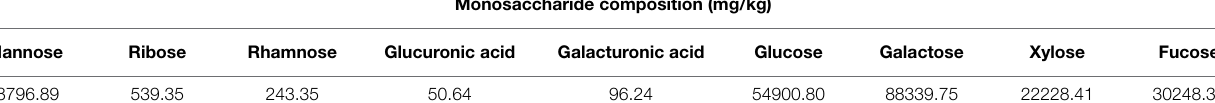
TABLE 1 | Monosaccharide composition of the FVPs.